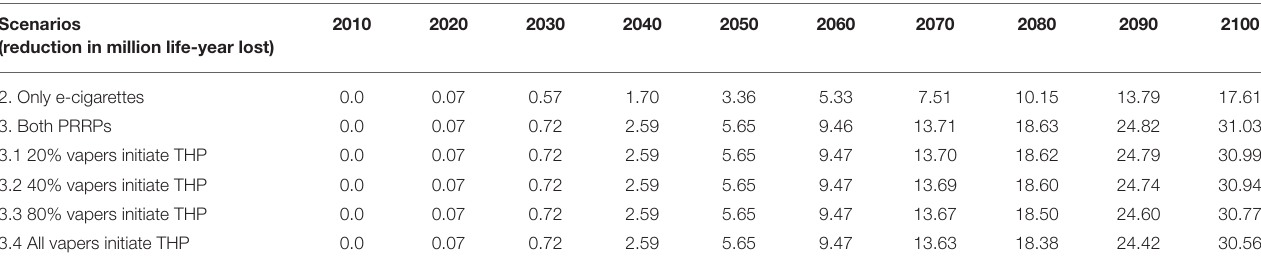
TABLE 3 | Life-years saved by 2100 when comparing scenario 2 (cigarettes and e-cigarettes available) and scenario 3 (all three products) to scenario 1 (only cigarettes available). Scenarios (reduction in million life-year lost)